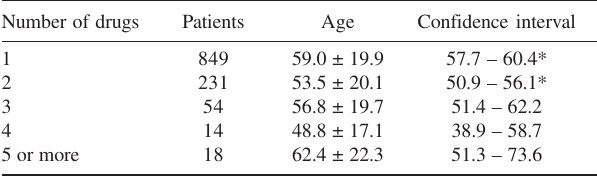
Table 2 - Age distribution according to number of anti- infective agents administered (Test group, n = 1166) Number of drugs